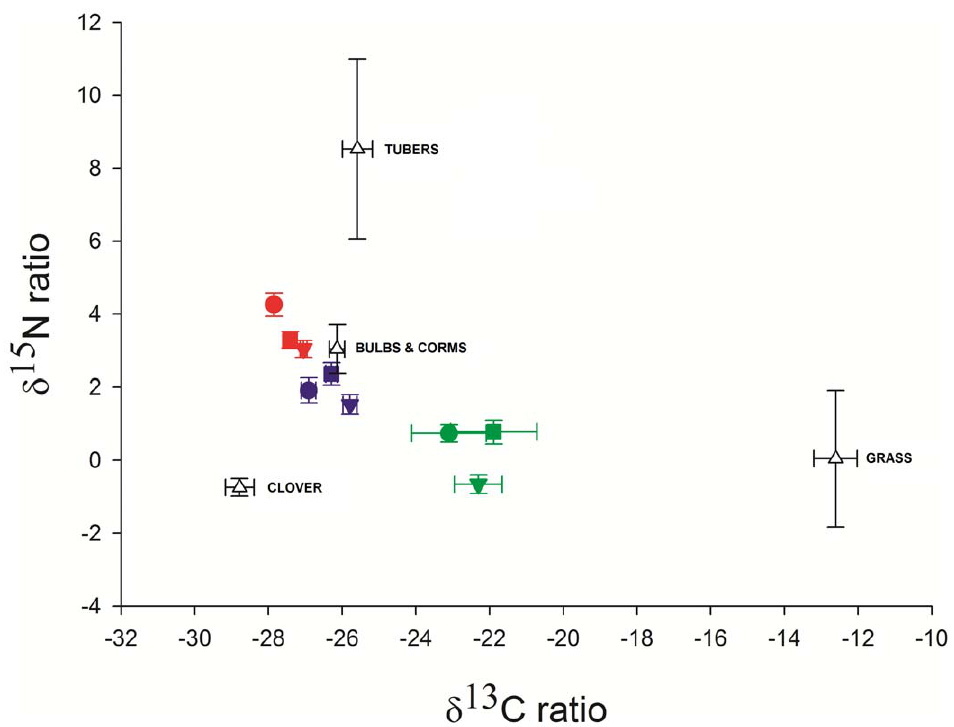
Figure 2. Mean stable isotope compositions of the three species ( C.h.hottentotus= red, G.capensis= blue and B.suillus= green). Tissues are shown by shape of symbols (circle=blood, square=claw and triangle=fur). Error bars represent 6 1 standard error. Mean values ( + / 2 se) are also shown for the main food sources (white triangles). All animal tissues have been corrected using appropriate discrimination values.